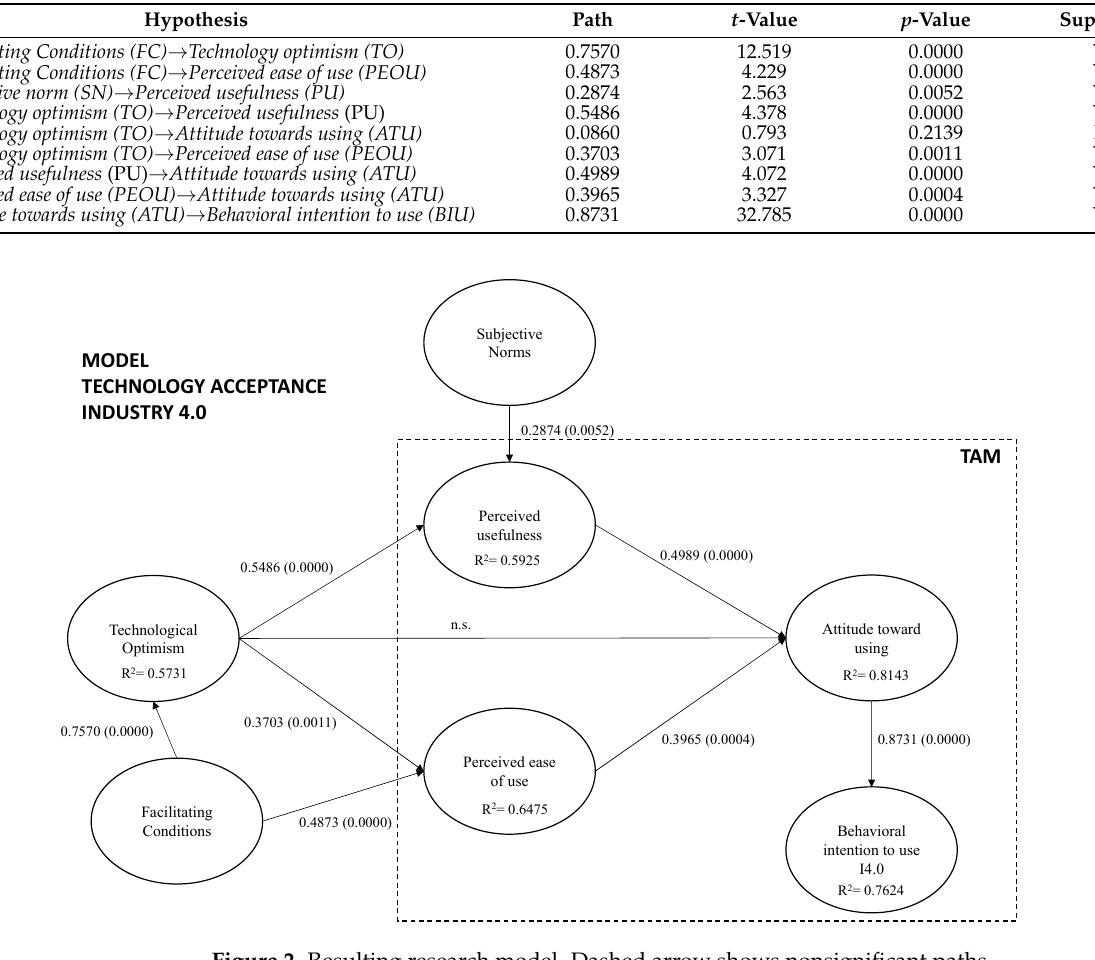
Table 5. Results from the structural model.